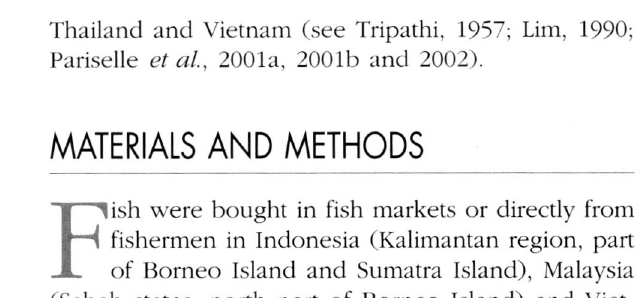
Fig. 1. - Measurements used in this study. C = cuneus: L = length; 1 = largest width; e = extension length. DB = dorsal transverse bar: x = total length; w = width in the middle. DG = dorsal gripus: a. b, c, d and e = stan­ dard measurements. MA = male apparatus: Pe - total length of the penis; Ap = length of the accessory piece; He = length of the heel. U = total length of the uncinuli. VB = ventral transverse bar: x = length of one branch; w = largest width. VG = ventral gripus: a, b, c, d and e = stan­ dard measurements; L and 1 = length and width of gripus